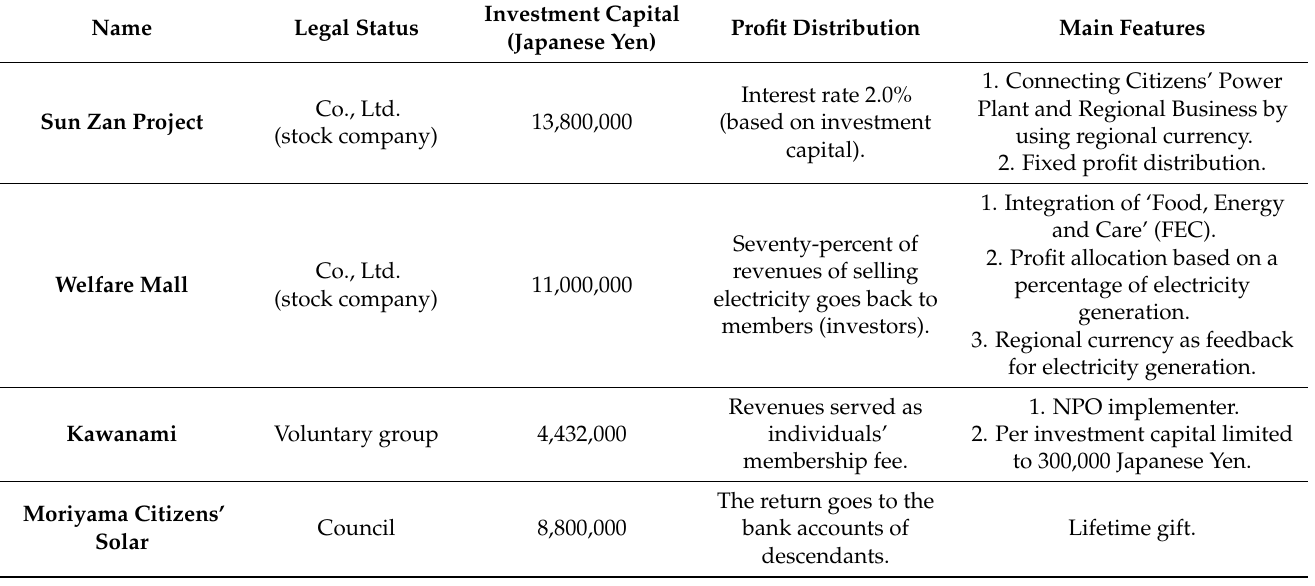
Table 2. Features and Operation: Four models of Citizens’ Co-Owned Power plants in Shiga